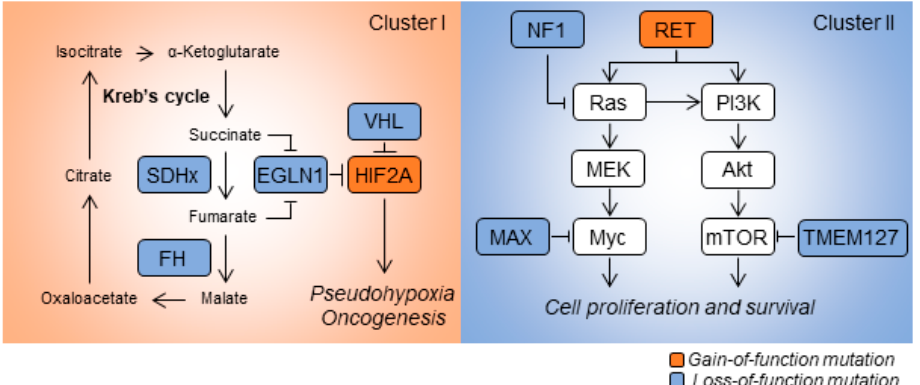
Figure 1. Schematic illustrations of cancer-associated mutations in pheochromocytomas and paragangliomas (PCPGs). Cluster I PCPGs exhibit dysfunction in the Krebs cycle and hypoxia